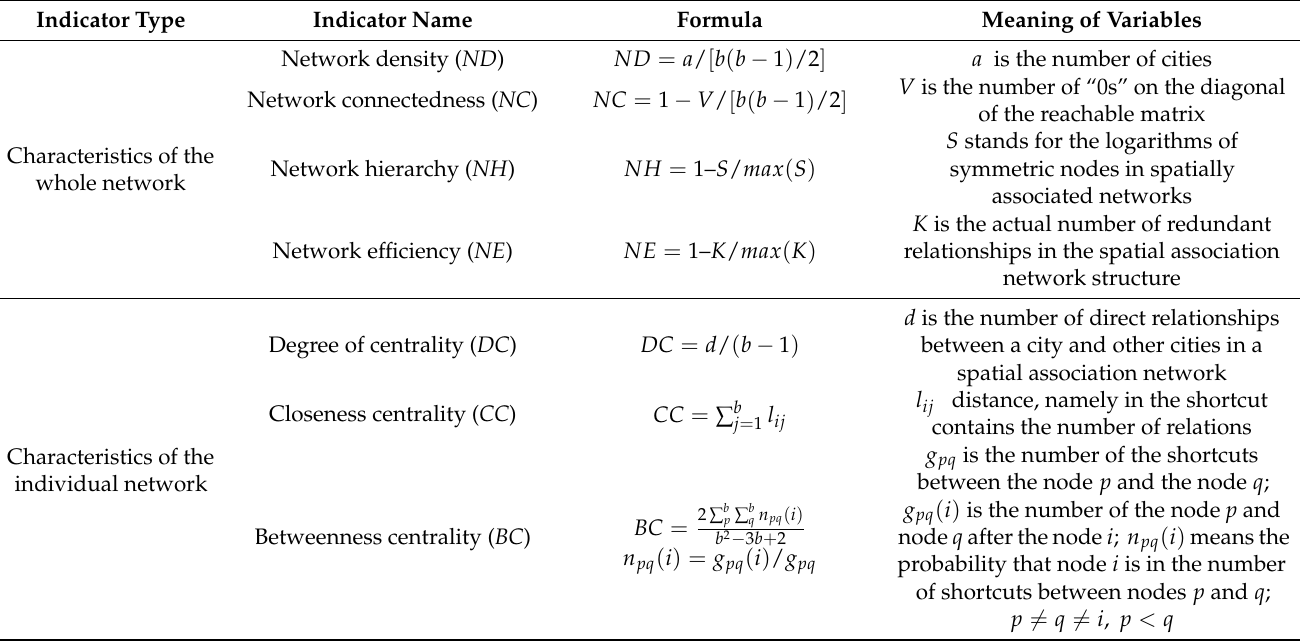
Table 2. Formulas for the structural characteristics of spatial correlation network of tourism eco-